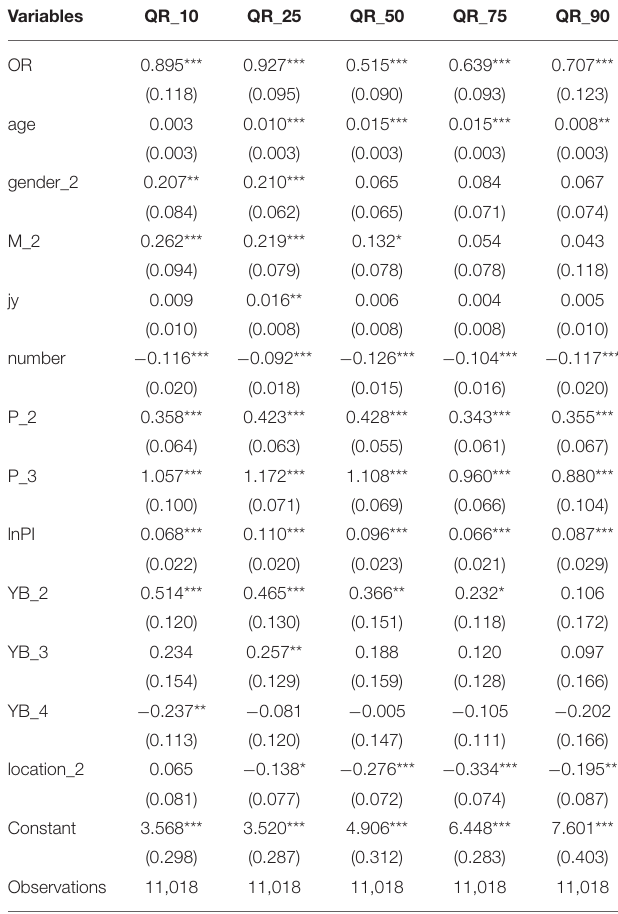
TABLE 4 | Regression results of household health expenditure in eastern